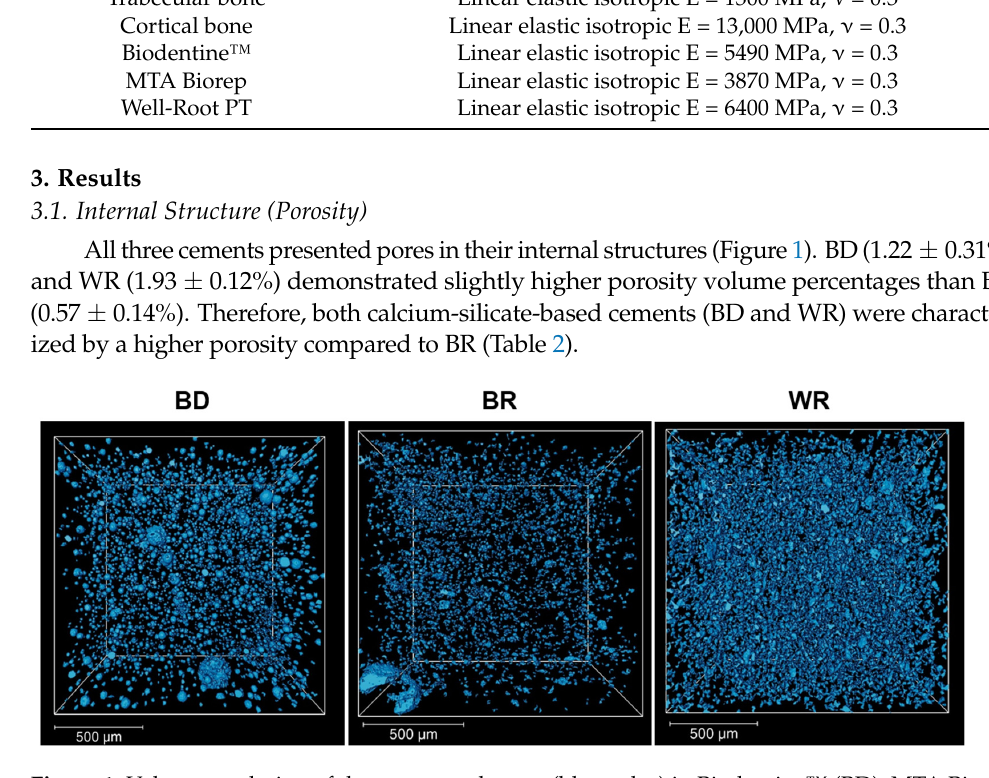
Figure 1. Volume rendering of the segmented pores (blue color) in Biodentine™ (BD), MTA Biorep (BR), and Well-Root PT (WR) obtained by X-ray tomography analysis. The scale bar corresponds to 500 µm in all the images. Table 2. Pore volume fraction and average pore equivalent diameter obtained by X-ray